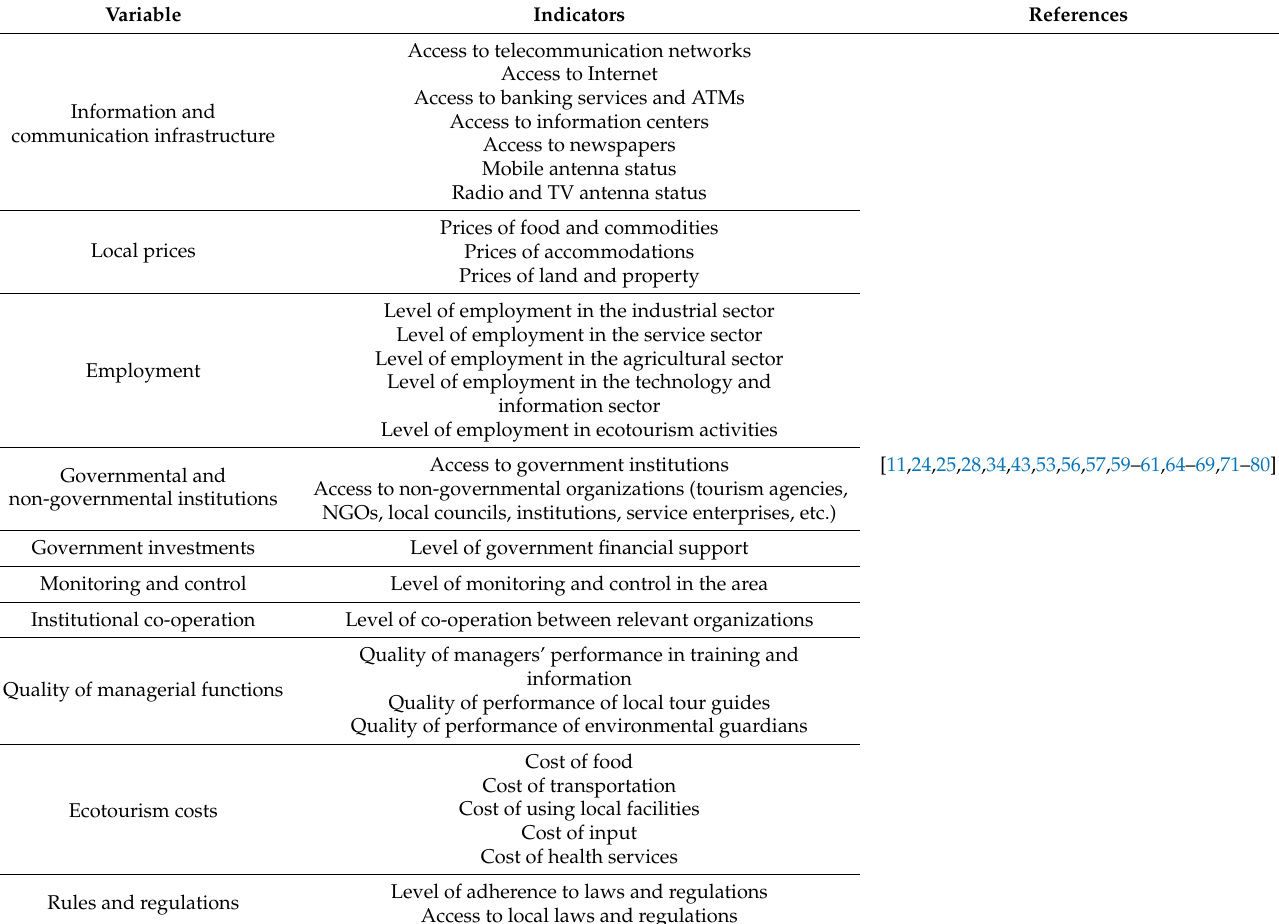
Table 4. Sustainable ecotourism indicators in the economic–institutional